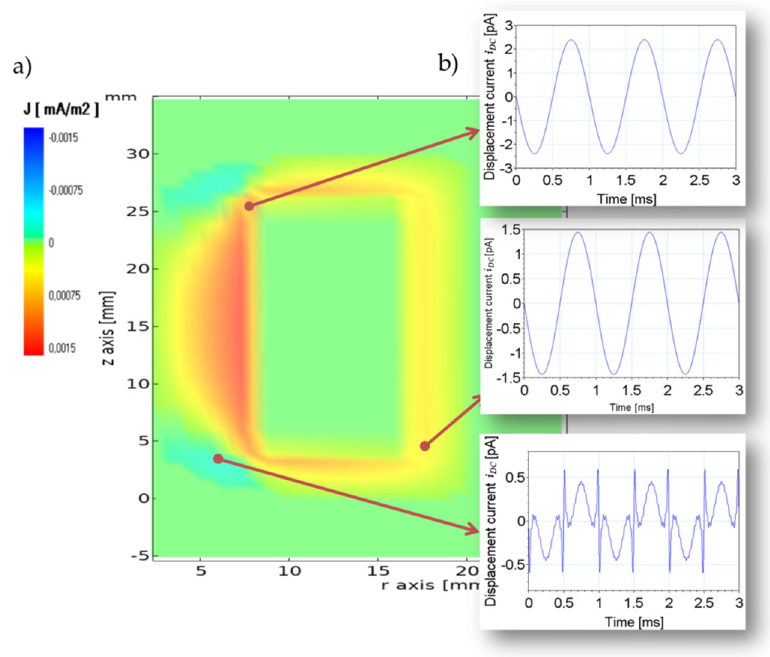
Figure 8. Distribution of the displacement current density in the ferrite core for time t = 0.92 ms ( a )